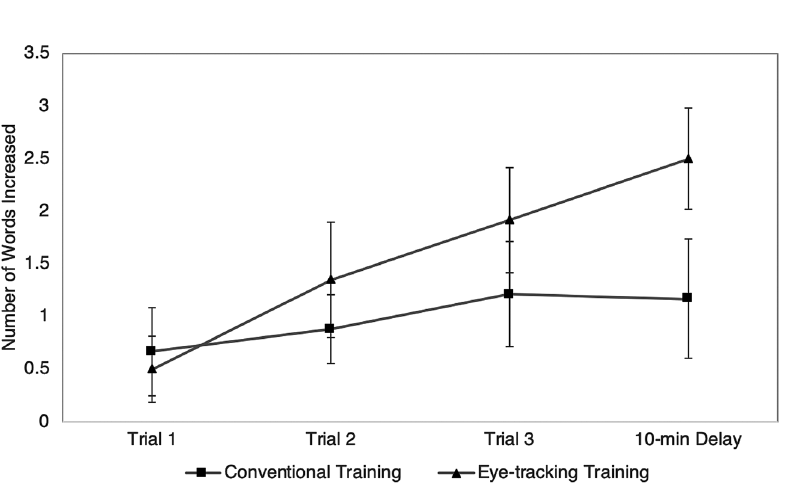
Figure 1. The increase in the number of words recalled across three learning trials and a delayed recall trial of the Hong Kong List Learning Test after training in two groups. The error bar represents one standard error of the